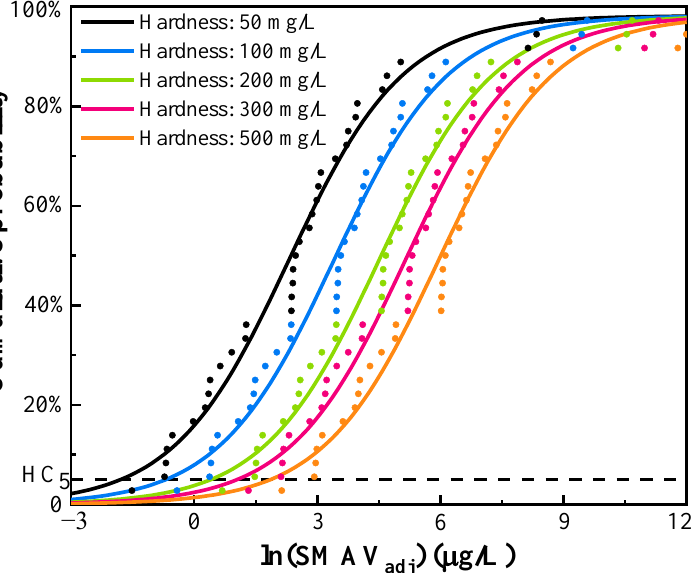
Figure 3. The SSD curves of silver ions for different hardness levels (50, 100, 200, 300, and 500 mg/L as CaCO 3 ).